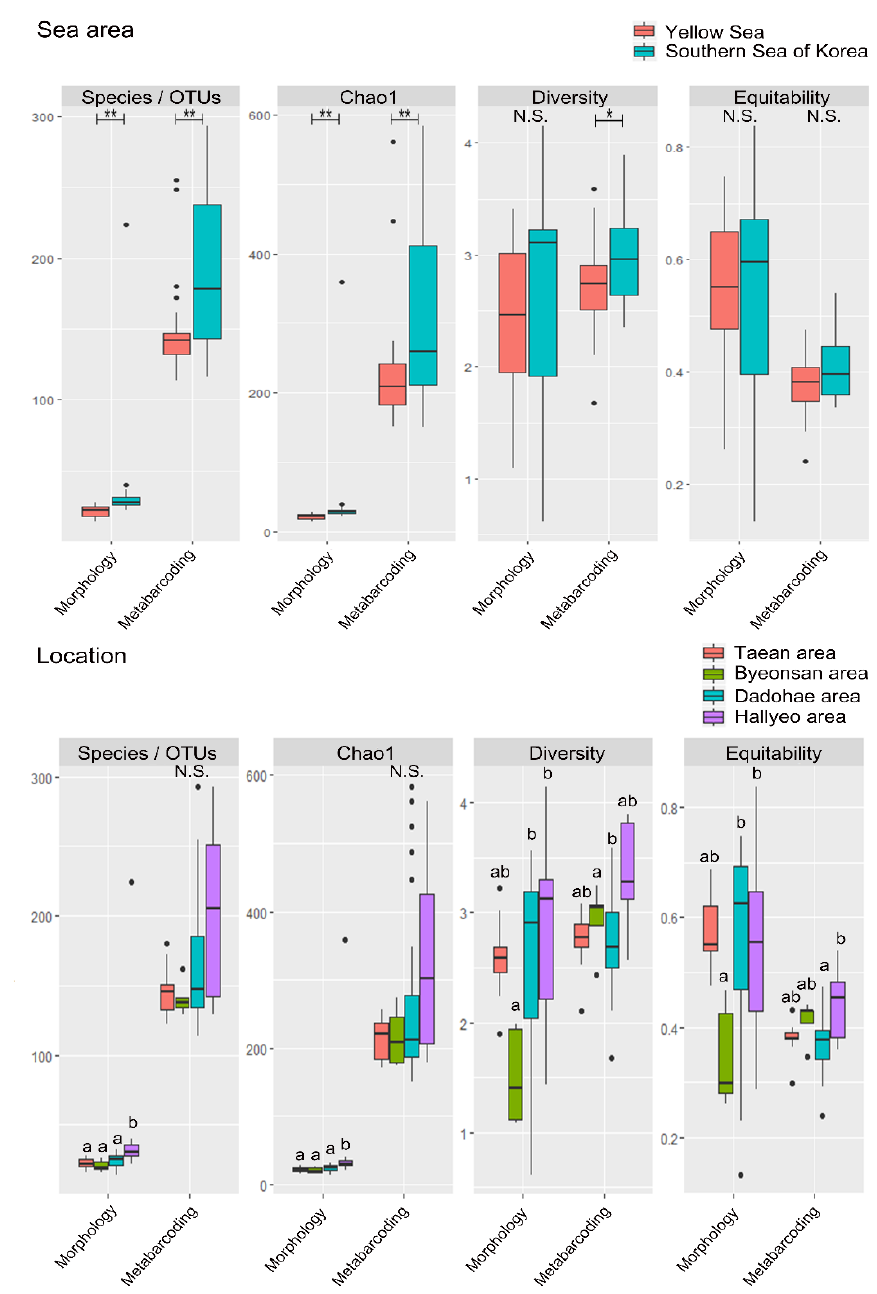
Figure 2. Comparison of mesozooplankton biodiversity indices in the Marine and Coastal National Park areas of Korea. Boxplots for the mesozooplankton biodiversity indices were calculated using morphological identification and metabarcoding results according to the sea area and location. Statistical di ff erences in the biodiversity indices according to the sea area were calculated using the Wilcoxon rank sum test. As a post hoc analysis, all p -values were corrected using the Benjamini–Hochberg procedure (** p < 0.01, * p < 0.05, N.S. no significance). In the case of location, the significance of biodiversity indices was calculated using the Kruskal–Wallis test. As a post hoc analysis, pairwise comparisons were conducted using Dunn’s test. The results for Dunn’s test were marked using the same letter for values that were not significantly di ff erent from each other. OTUs are operational taxonomic